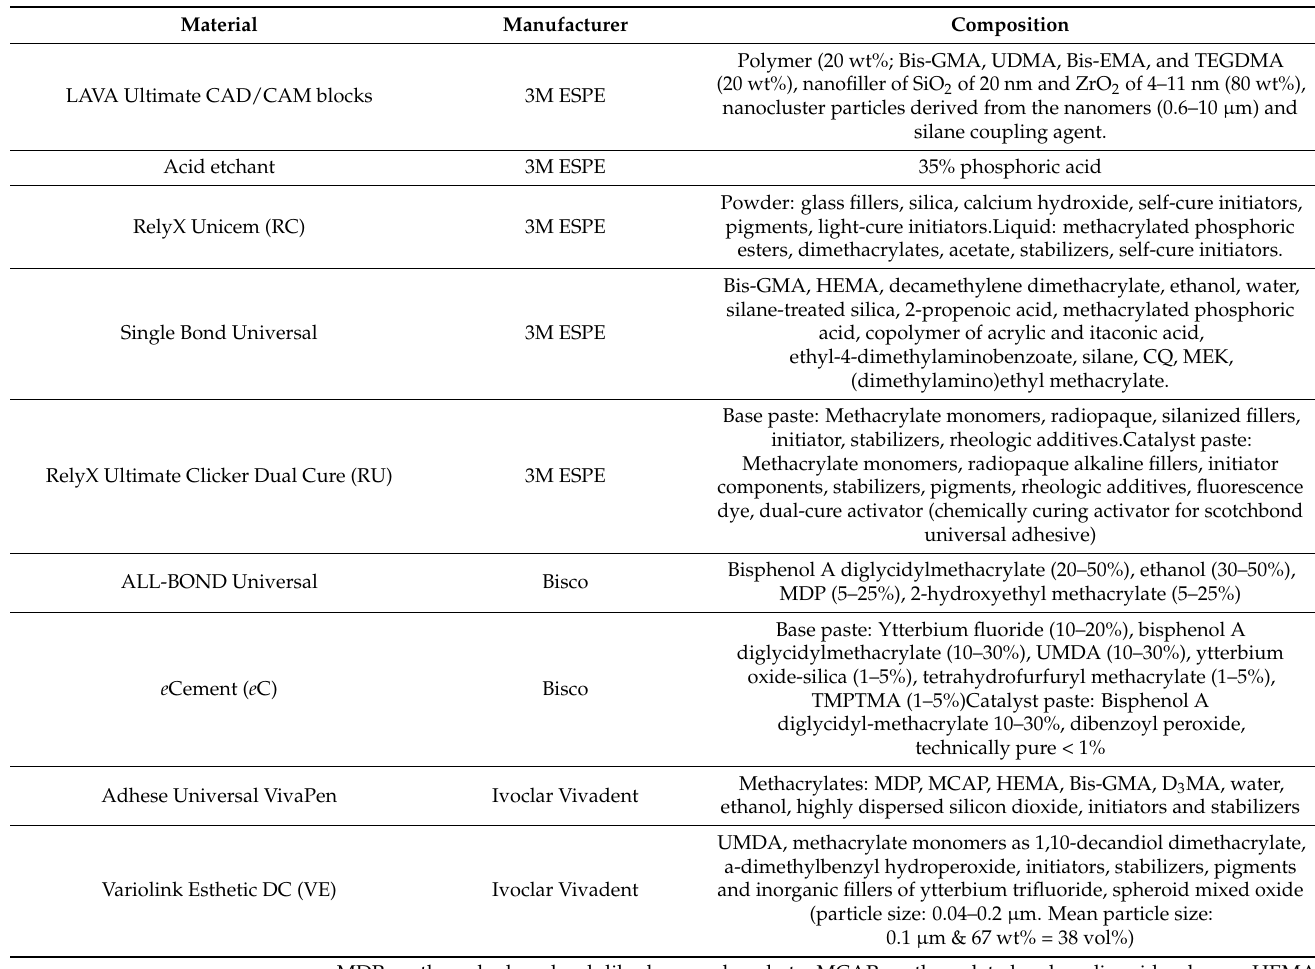
Table 1. Materials